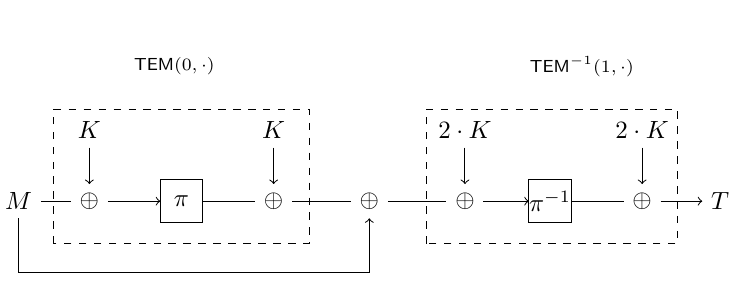
Figure 4: The construction